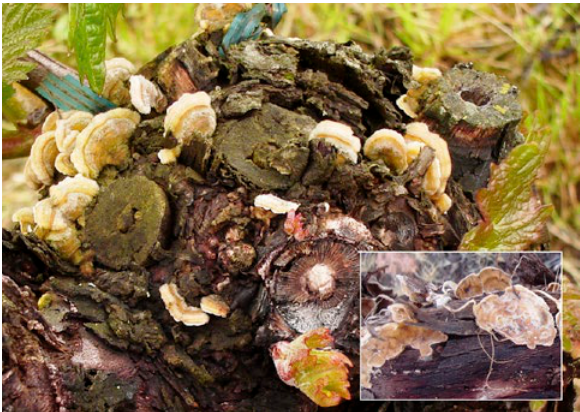
Figure 9. Fruitbodies of Stereum hirsutum on grapevine bark showing upper and hymenial surfaces; note appearance in groups and on uppermost part of trunk. Photograph: V.